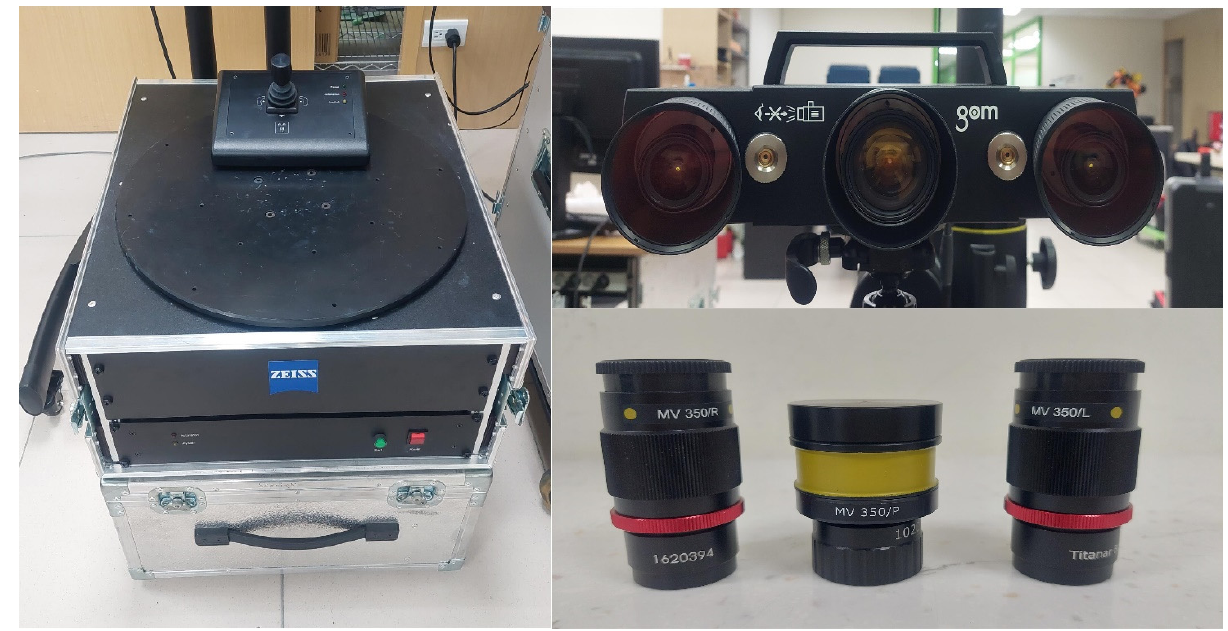
Figure 3. 3D digitizing instruments used in study.